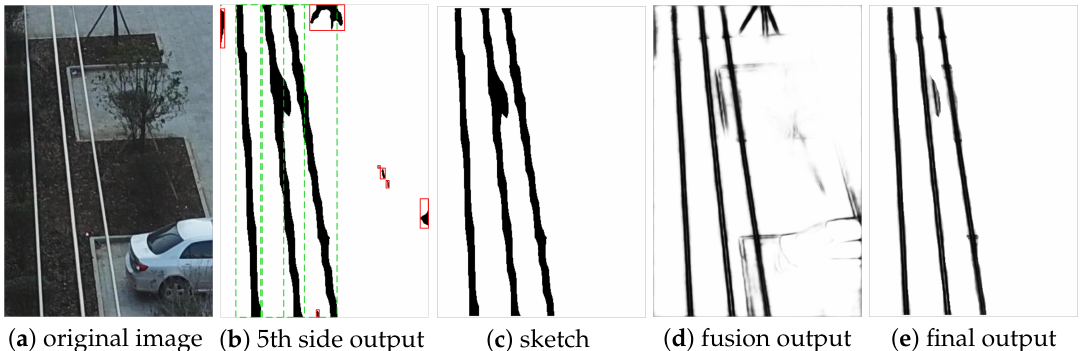
Figure 3. The intermediate outputs in the process of structure